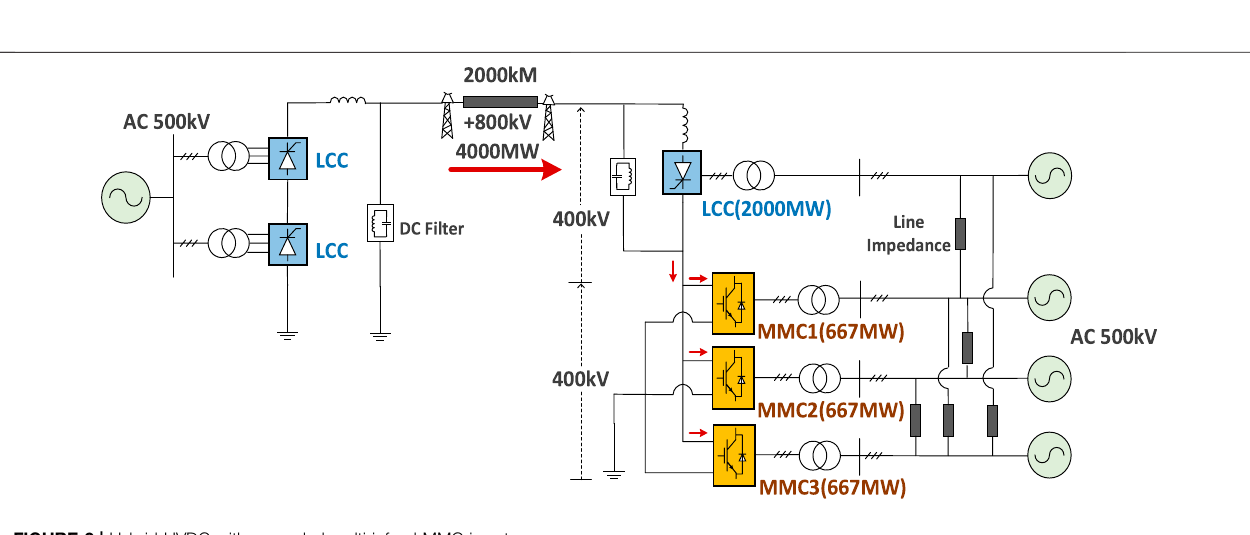
FIGURE 2 | Hybrid HVDC with cascaded multi-infeed MMC